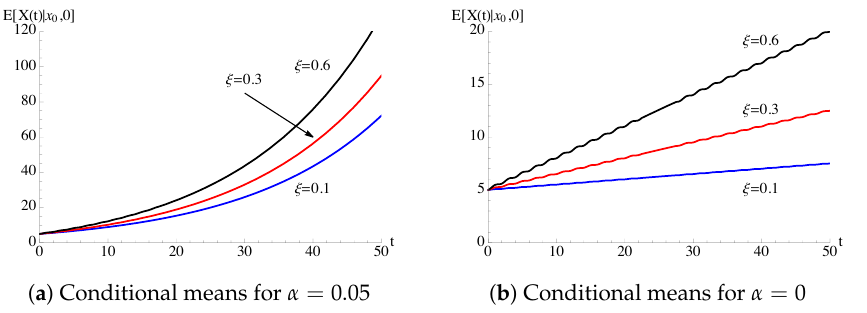
Figure 4. For the process of Figure 3, the conditional means are plotted as function of t for various choices of ξ .